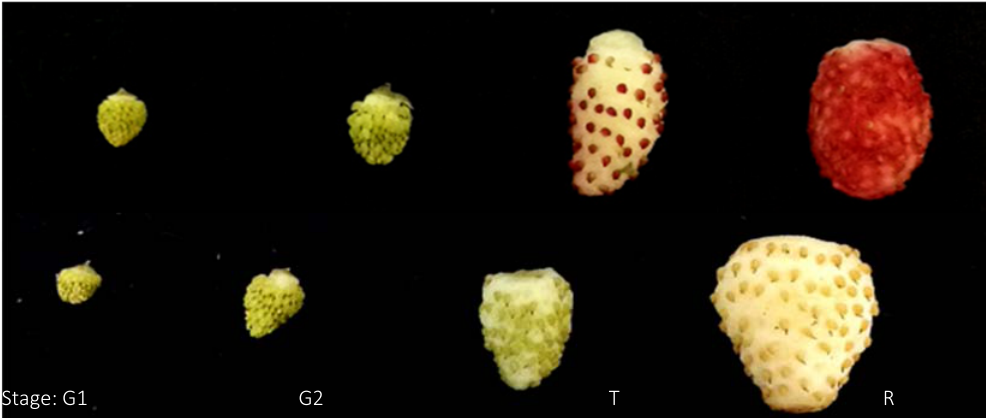
Figure 1. Four developmental stages of Baron Solemacher (top row) and Pineapple Crush (bottom row). From left to right: early green (G1) with no spacing between achenes, intermediate green (G2) with spacing between achenes and green receptacle exposed, turning (T) with the receptacle becoming pinkish-white and achenes becoming red for BS and the receptacle becoming white for PC, and ripe (R) with a soft red receptacle for BS and soft white receptacle for PC.